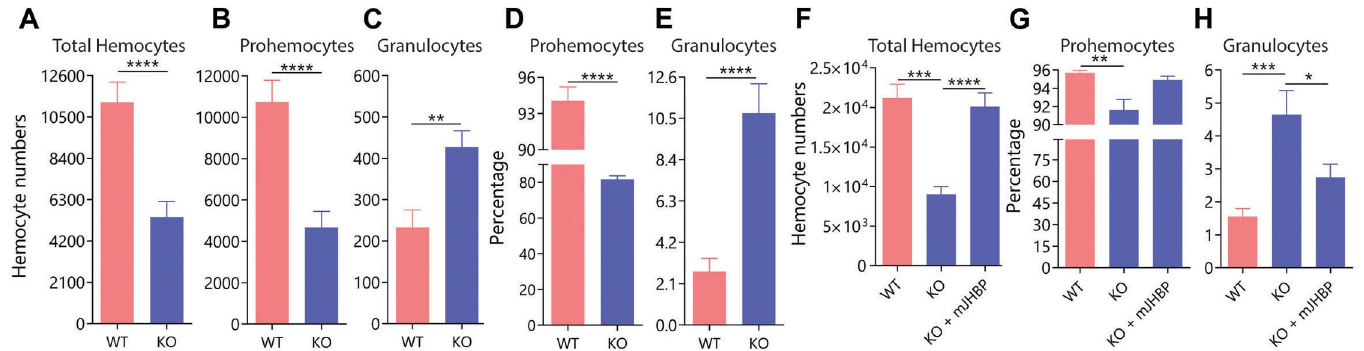
Fig 7. mJHBP-deficient mosquitoes exhibit impaired hemocyte development (lower hemocyte counts) and increased granulocyte differentiation. Relative abundance (Mean number ± SEM) of total hemocytes ( A ), prohemocytes ( B ) and granulocytes ( C ) per female in newly-emerged WT and KO lines. Relative proportion (%) of prohemocyte ( D ) and granulocyte ( E ) subpopulations in in newly emerged WT and KO lines. Relative abundance (Mean number ± SEM) of total hemocytes ( F ), as well as the proportions of prohemocytes ( G ), and granulocytes ( H ) perfused from newly emerged WT and KO adults reared to eclosion after injection of fourth instar larvae with buffer or biologically active mJHBP. Significance levels (Mann-Whitney U) are indicated with asterisks ( ���� p � 0.0001, ��� � 0.001, �� � 0.01, � � 0.05). In panels A-E two biological replicates of 10 female mosquitoes each were counted. In panels F-H , two biological replicates of 4–7 mosquitoes each were performed.